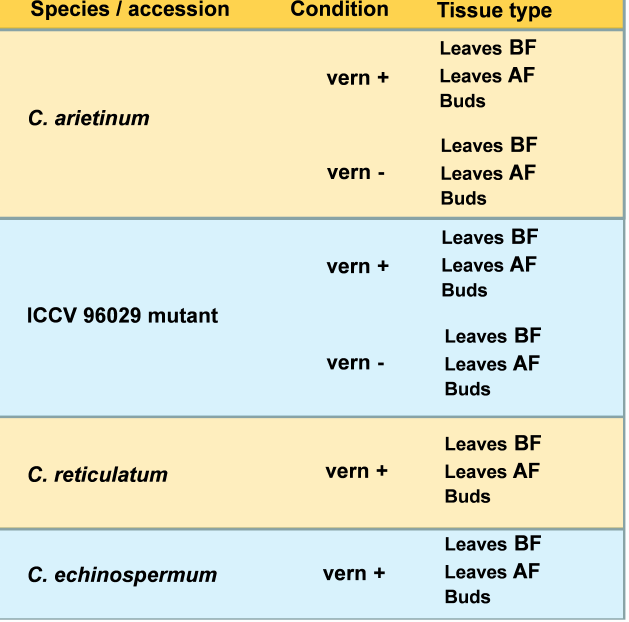
Figure 8. The dataset used for analysis of differential gene expression. ’leaves BF’—leaves be- fore flowering initiation, ’leaves AF’—leaves after flowering initiation, ’buds’—early flower buds, ‘vern+’—after vernalization, ‘vern-’—without